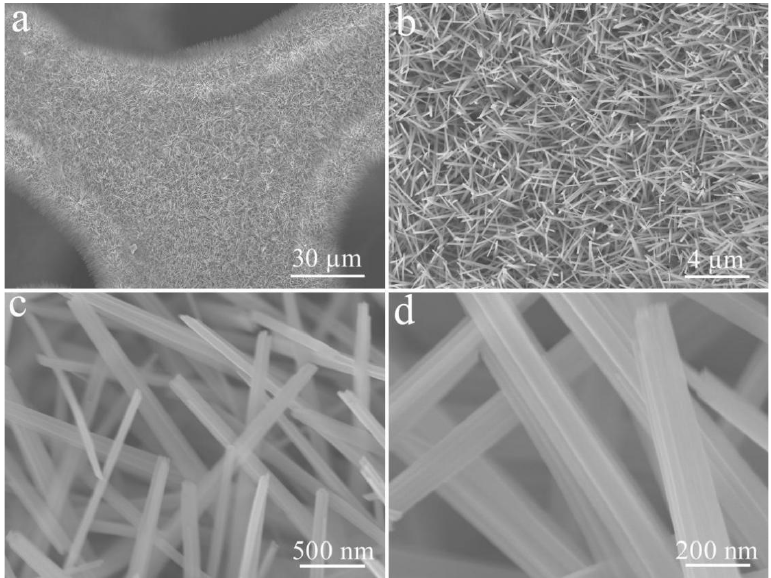
Figure 2. ( a , b ) Low-magnification and ( c , d ) high-magnification FE-SEM images of Cu(OH) 2 nanorods grown on copper foam.